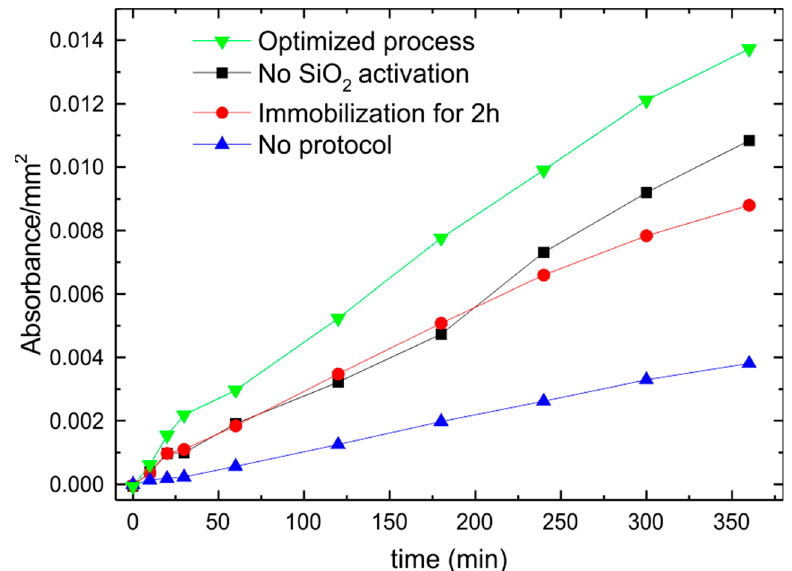
Figure 8. GOx activity as a function of time for a SiO 2 samples fully processed with a protocol: optimized ( green triangles ); not including the oxide activation ( black squares ); with a GOx immobilization time of 2 h ( red dots ). The comparison with a sample that underwent only to the GOx immobilization step ( blue triangles ) is also shown for comparison.